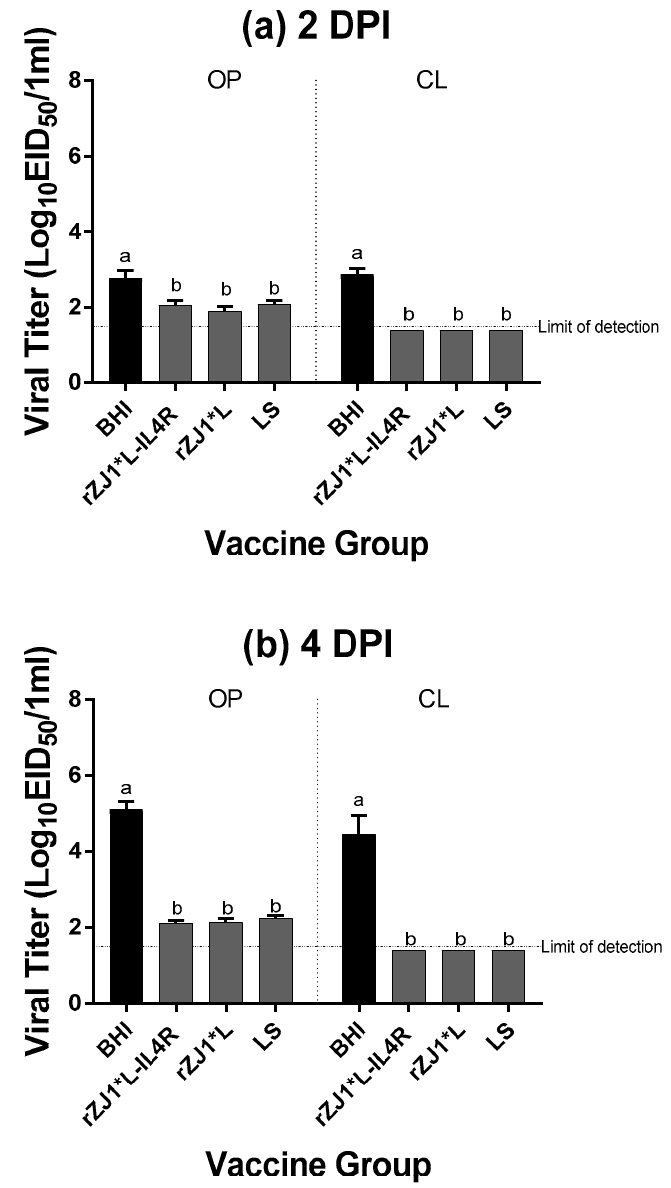
Figure 8. Effect of rZJ1*L-IL4R vaccination at 19 DOE on Post-Challenge Viral Shedding. At 19 DOE, SPF embryonated chicken eggs were vaccinated in ovo with 10 3.5 EID 50 /egg of rZJ1*L-IL4R, rZJ1*L, LS or with brain heart infusion (BHI). At 14 DPH, 12 chicks from each group were challenged with 10 5 EID 50 of vZJ1 via the oculo-nasal route. Viral titers from the oropharyngeal (OP) and cloacal (CL) routes were measured at 2 ( a ) and 4 DPC ( b ). At 4 DPC, shedding was determined from n = 12 chickens/vaccine group except for the sham-vaccinated -challenged group, in which only 2 chickens remained alive. Reference line denotes the average limit of detection. Group means were analyzed using One-way ANOVA followed by a multiple comparisons Tukey’s test, with a level of significance of p ≤ 0.05. Groups with different letters are significantly